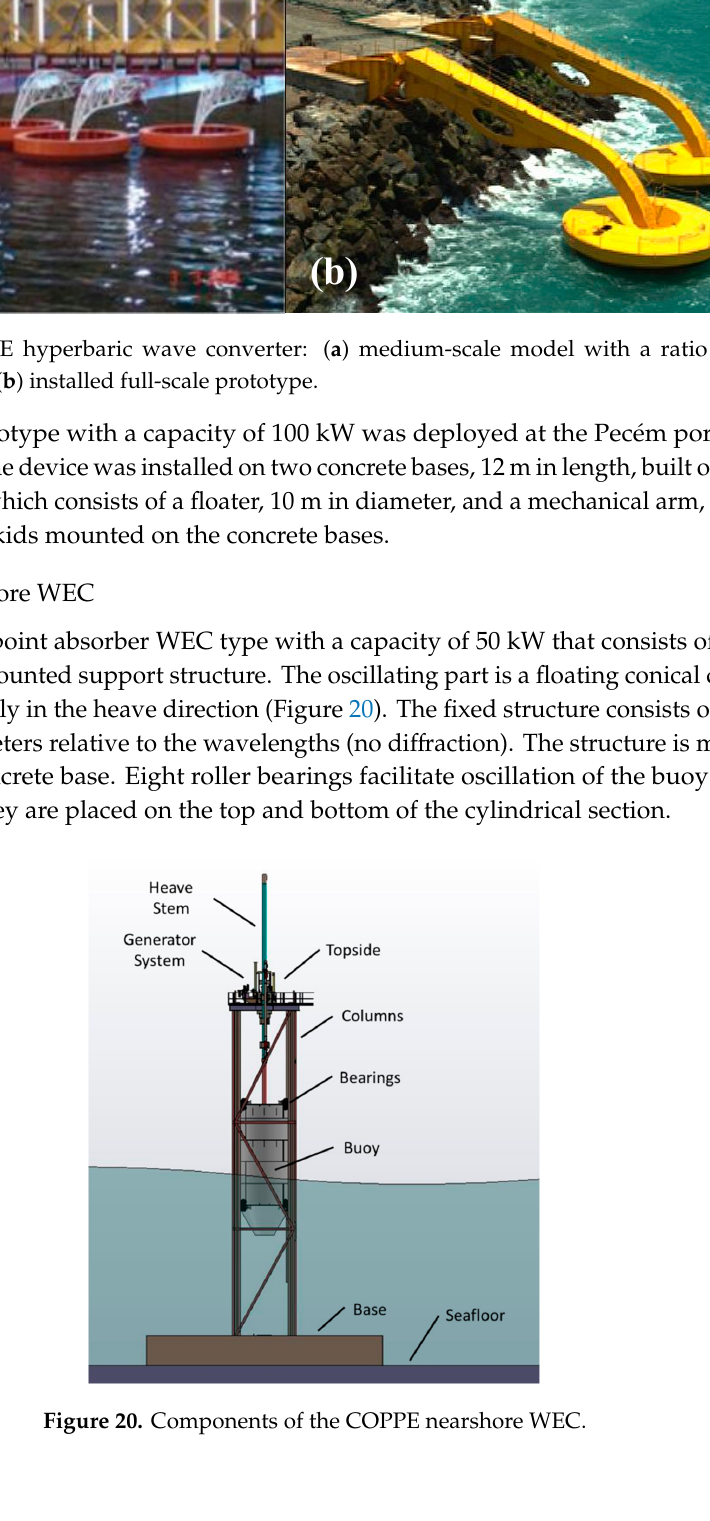
Figure 21. Schematic view of the power take-off (PTO) system. Experimental tests of small-scale models, shown in Figure 22, were performed in a wave and current channel (LOC) at the COPPE/UFRJ. The hydrodynamic behavior of the buoy was studied by applying different modeling scales including 1:17, 1:20, 1:30, and 1:40. Additionally, a strategy was developed to investigate the effect of latching control on the WEC. Figure 22. Experimental tests of the COPPE nearshore WEC in a wave channel: ( a ) 1:17 scaled model, ( b ) instruments for data acquisition. 4.2.3. Tidal Power Plant of the Estuary of Bacanga